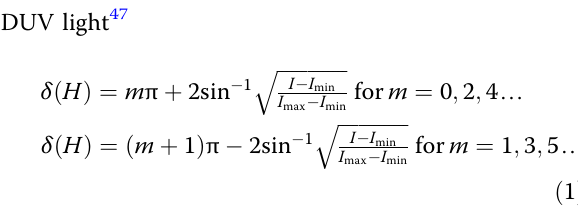
transmittance in parallel and orthogonal directions of Poynting vector with respect to external magnetic fi eld (Fig. 4a and Supplementary Fig. S4). At zero fi eld, the CTO fl akes orient randomly, exhibiting isotropy with an optical transmittance of 47% at 303 nm. Upon increasing magnetic fi eld, the CTO fl akes rotate and align parallel to the fi eld by magnetic torque Γ ¼ M ´ H